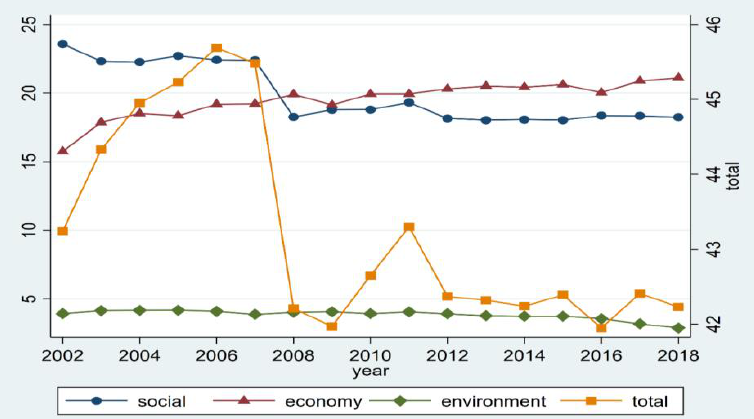
Figure 2. Trends in the vulnerabilities of low-carbon energy in OECD countries from 2002 to 2018. Note: The magnitude of the left vertical axis refers to the social vulnerability, economic vulnerability, and environmental vulnerability. The axis unit is 100%.